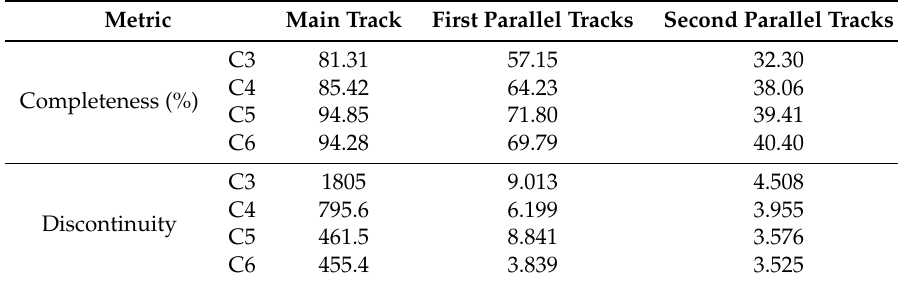
Table 3. Averaged Completeness and Discontinuity of tracks mapped in combinations 3 to 6.